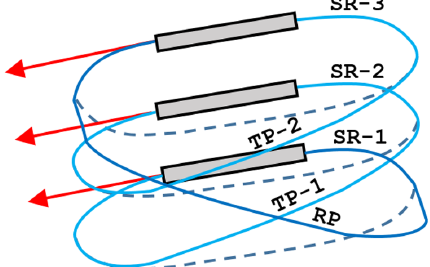
°.FIG. 2. Schematic layout of the Spiral-COSAMI lattice (from